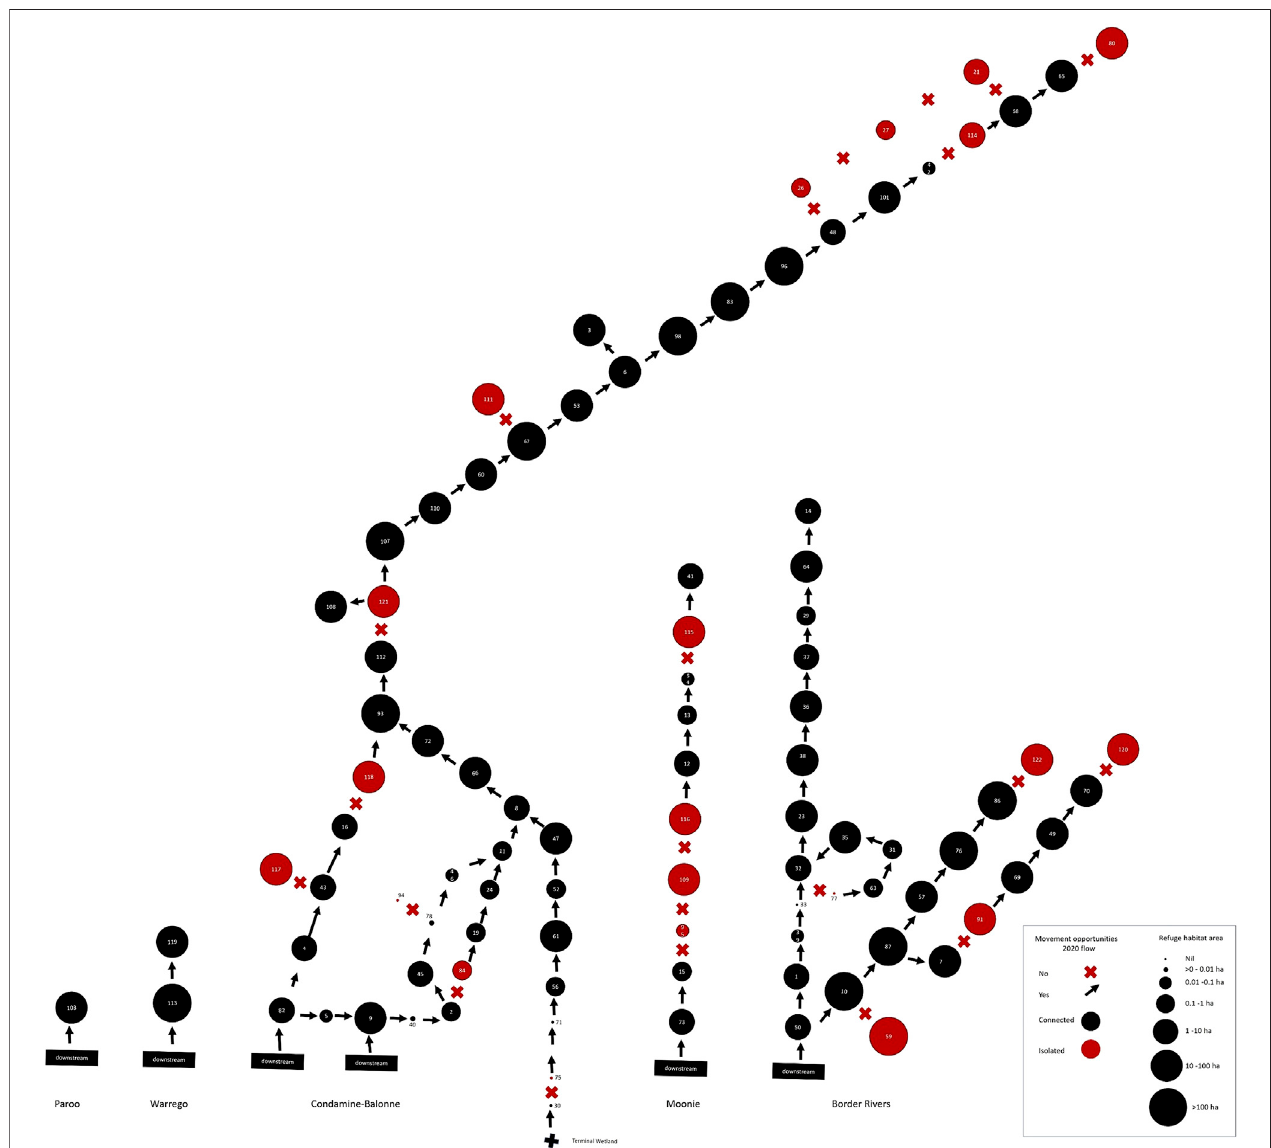
FIGURE 8 | Spatial, patch-based graph representing both peak drought waterhole availability per river segment as the size of the circles, and provision of fi sh movement opportunities past segment-de fi ning barriers from the drought breaking fl ows in 2020. Arrows indicate opportunity and crosses lack of opportunity. Red circlesindicateriversegmentsisolatedbybarriers.Thisillustratesthecombinedresistanceandresilienceriskstolocal fi shpopulationsacrosstheQMDBregionfromthe 2018 – 2020 drought.